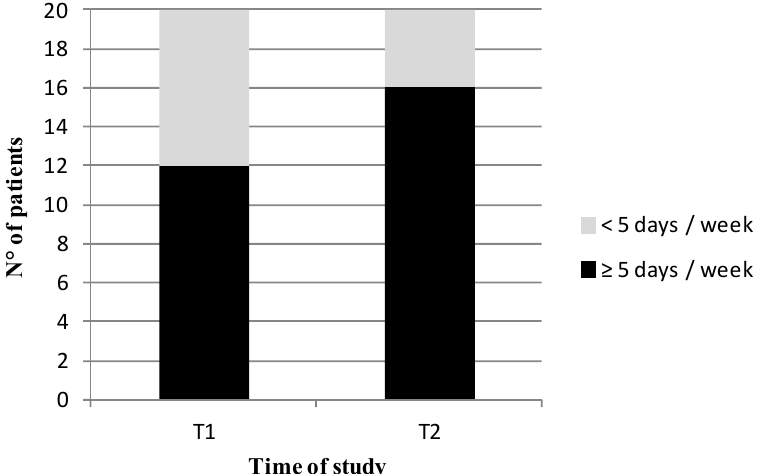
Figure 4. Patients’ adherence to low-nickel diet. Adherence was defined by the number of days per week of low-Nickel diet ( ≥ 5 days/week) and was evaluated after 15 days (T1) and at the end of the study (after 30 days, i.e., T2).